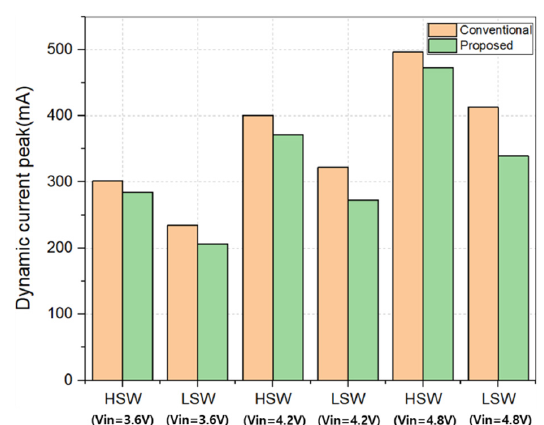
Figure 13. Measured regulation characteristics of proposed buck converter: ( a ) output line regulation and ( b ) output load regulation.